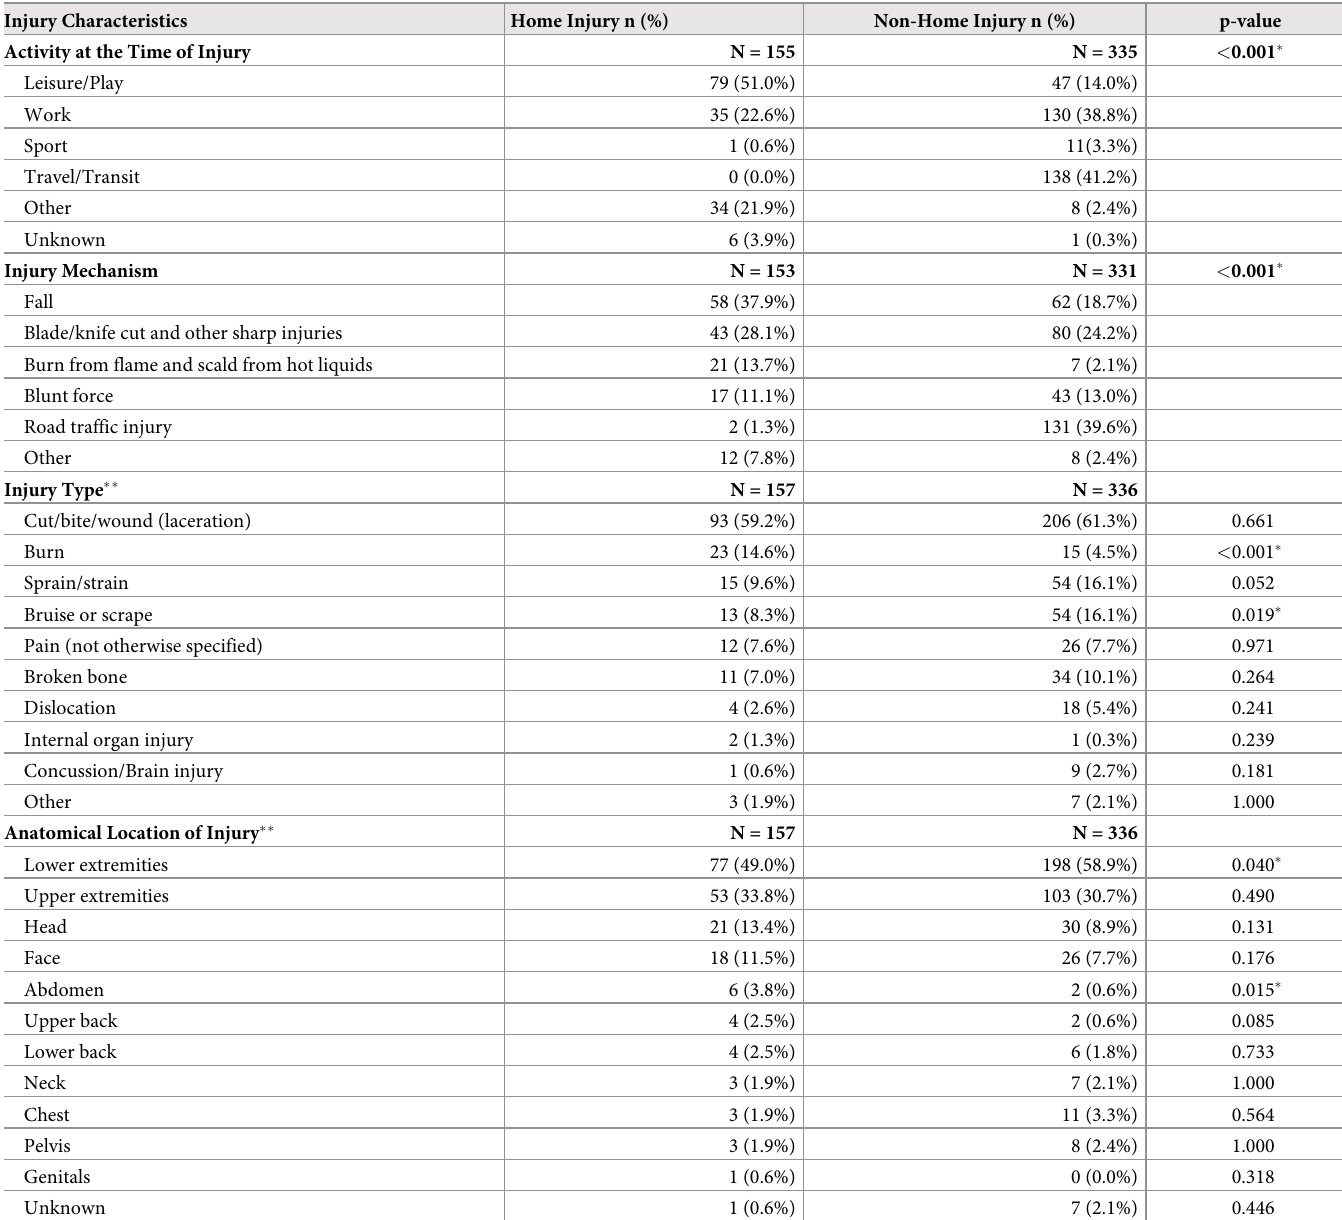
Table 2. Characteristics of home injuries in